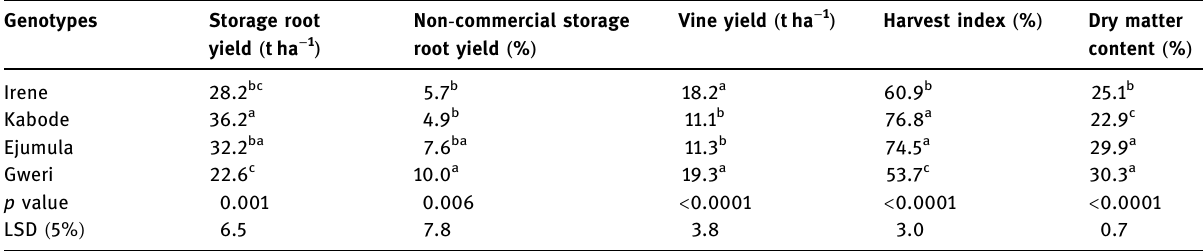
Table 5: Mean comparison for measured sweetpotato traits for the genotypes Genotypes